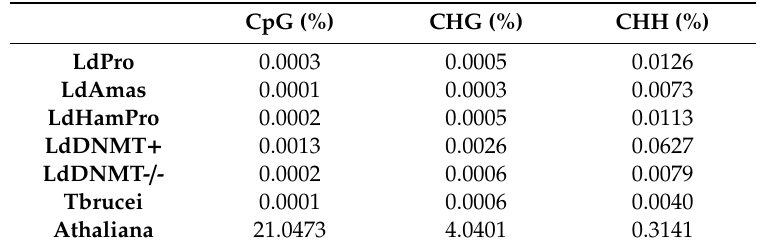
Table 1. CpG, CHG, and CHH methylation percentages in di ff erent Leishmania donovani lines (Ld), Trypanosoma brucei, and Arabidopsis thaliana (positive control).